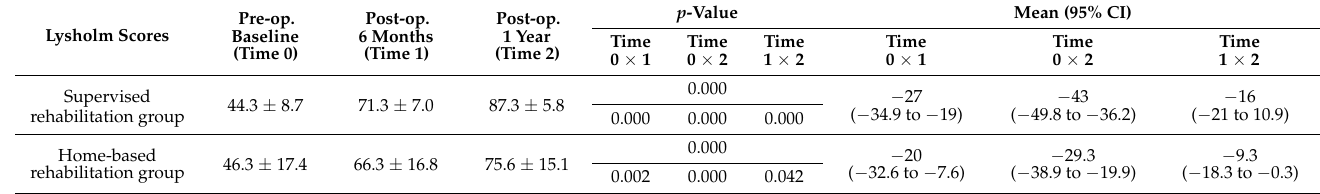
Table 6. Serial changes in Lysholm score of enrolled subjects in the supervised and home-based rehabilitation groups. Lysholm Scores